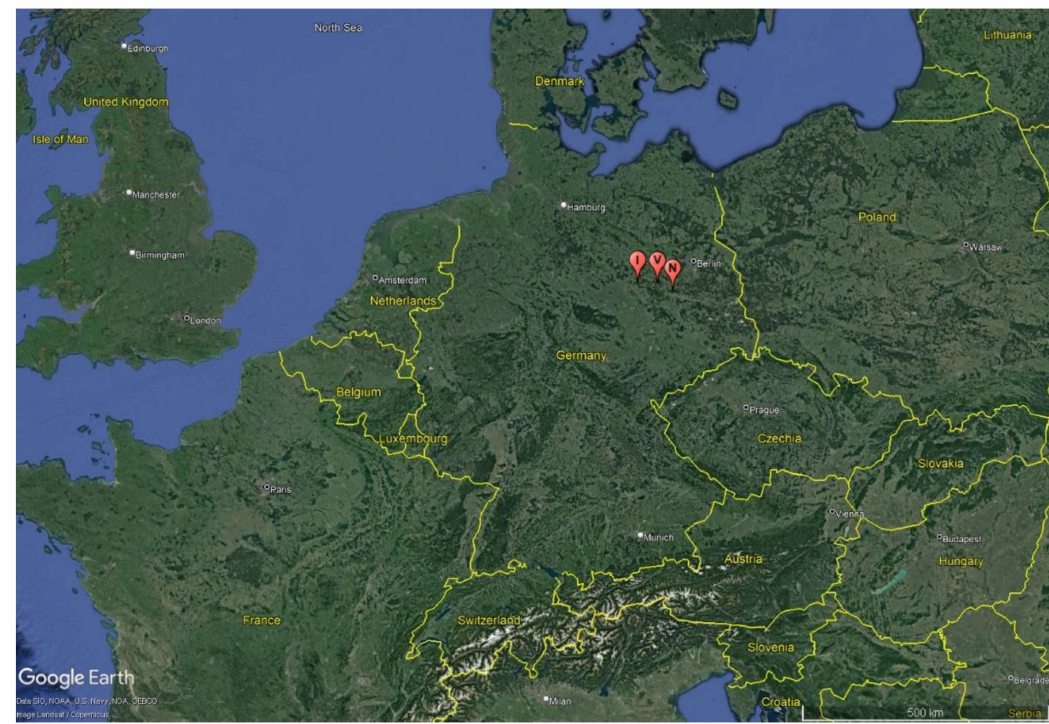
Figure 1. Location of sampled streams in Germany, published from google earth [8].